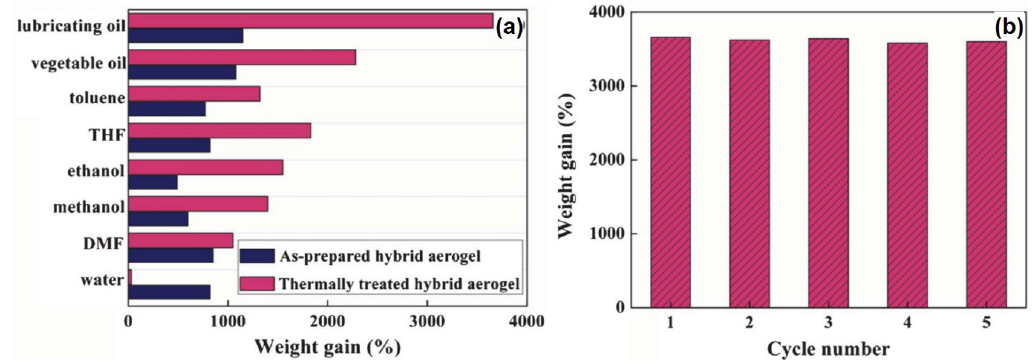
Figure 13. ( a ) The adsorption capacities of the MWNT ‐ carbon hybrid aerogels for a selection of several common solvents. ( b ) Cyclic performance of the thermally treated MWNT ‐ carbon hybrid aerogels for oil adsorption in five cycles. Reproduced with permission of [202] (Copyright The Royal Society of Chemistry 2013).